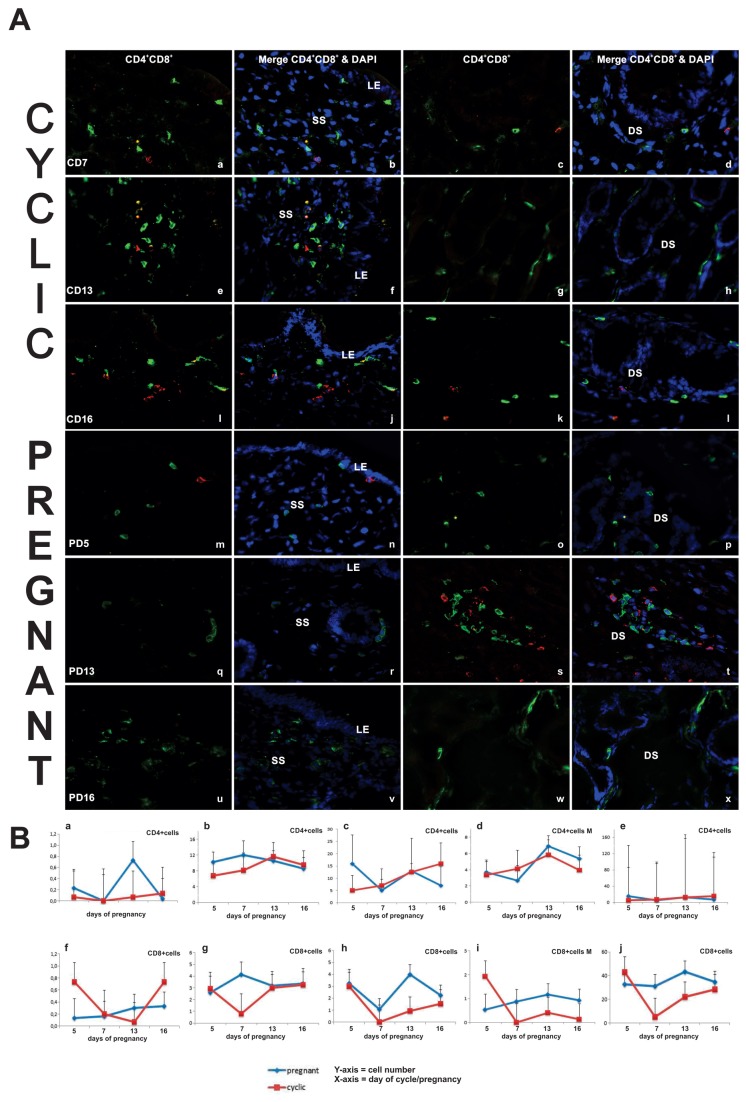
A) Immunofluorescent labeling of endometrial tissue for CD4+ and CD8+ T cells.(a-j) Representative images of immunofluorescent CD4+ cells labeling (green) and CD8+ cells labeling (red) and nuclei labeled with DAPI [blue]), in the endometrial shallow stroma (SS) ; deep stroma (DS) and myometrium (M) in cyclic at day 7 (a-d) ; 13 (e-h) and 16 (i-l) of estrus cycle and at day 5 (m-p) ; 13 (q-t) and 16 (u-x) of pregnancy. (original magnification ×40). B) Line graphs detailing the total number of endometrial CD4+  and CD8+ cells. CD4+ (a-e) and CD8+ (f-j) -cell numbers in cyclic (red line) and pregnant (blue line) endometrial tissue are based on the sum of immunofluorescent labeled cells per 2.25 mm2 field of view, in all areas (total CD4+ or CD8+) and specifically in the luminal epithelium (LE), SS, DS and M. Values plotted are least squared means and standard errors across 5 replicate animals per timepoint and per status.